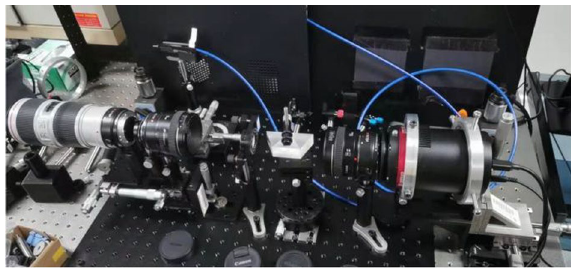
Fig. 8 The process of building a hyperspectral image acquisition